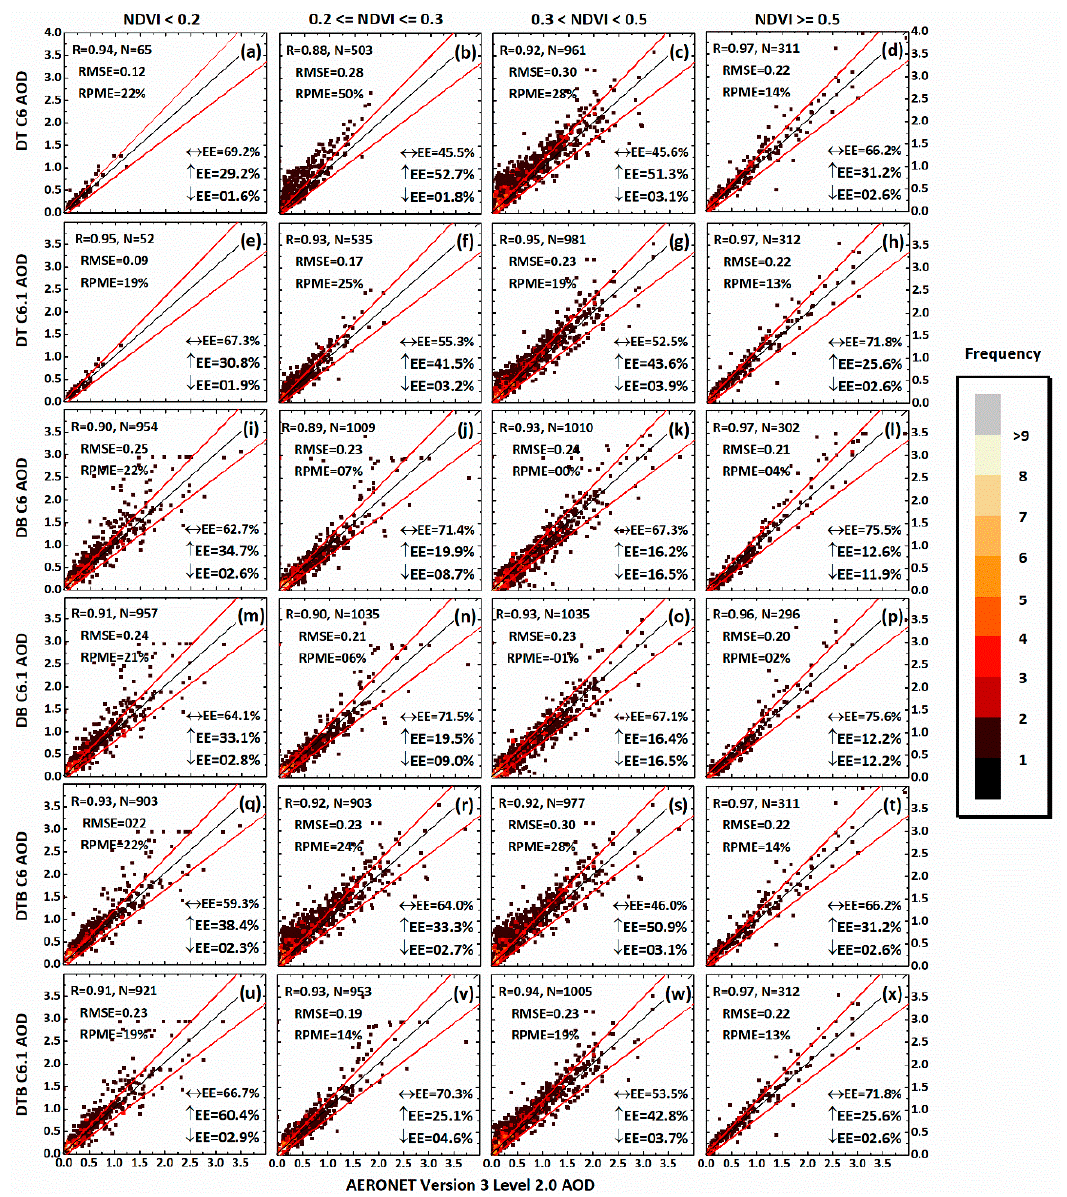
Figure 7. Validation of MODIS AOD retrievals from 2004–2014 over NVS, PVS, MVS, and DVS, where DT C6 ( a – d ), DB C6 ( e – h ), DTB C6 ( i – l ), DT C6.1 ( m – p ), DB C6.1 ( q – t ), and DTB C6.1 ( u – x ). The black line is the 1:1 line, and red lines are the expected error envelope.